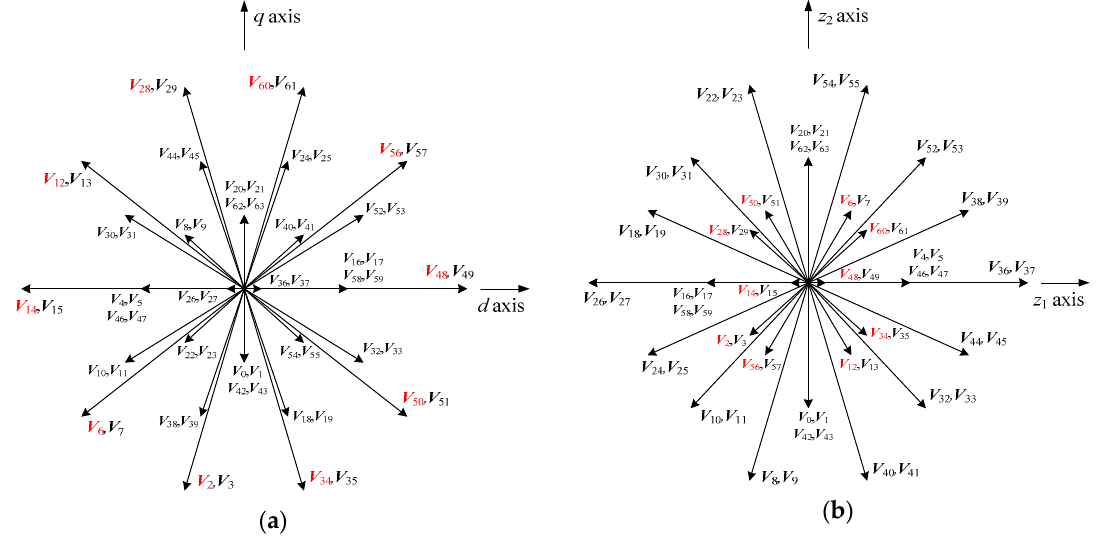
Figure7. 32 basic vectors in the d - q and z 1 - z 2 planes. ( a ) 32 basic vectors in the d - q plane; ( b ) 32 basic vectors in the z 1 - z 2 plane. vectors in the z 1 - z 2